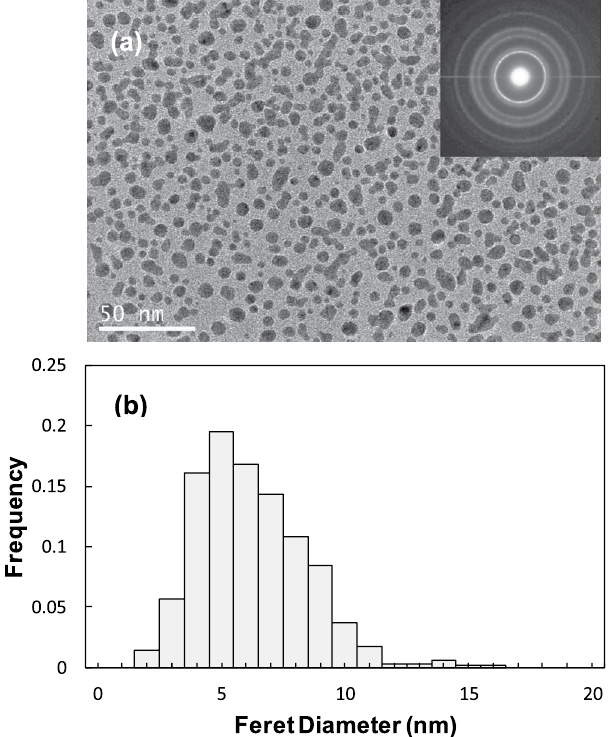
Figure 5. ( a ) TEM image and ( b ) size distribution histogram of the α -Al 2 O 3 nanocrystallites.